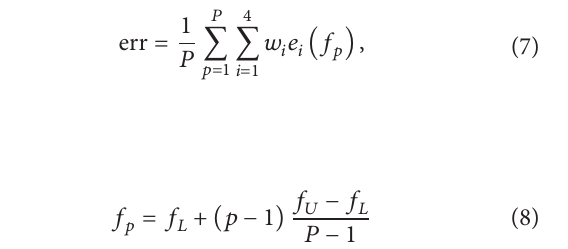
Figure 9: VSWR variation for helical antenna above ground